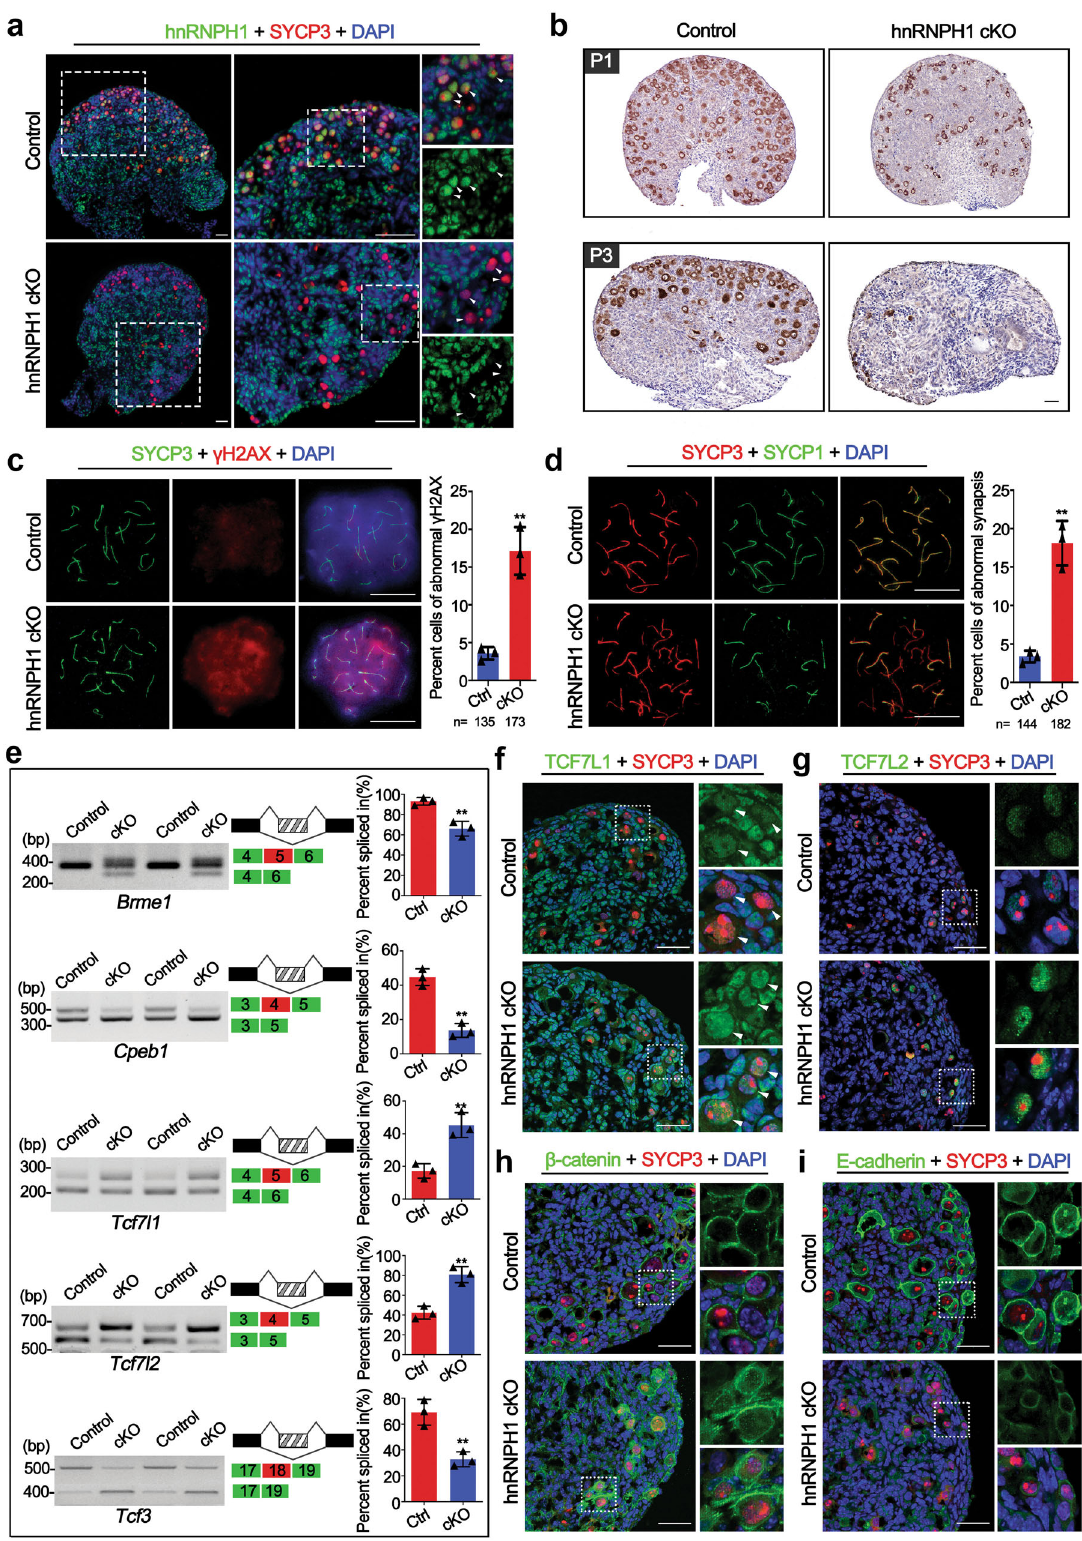
(Supplementary Fig. S11c), suggesting a splicing-independent mechanism underlying hnRNPH1 regulates gene expression. Since PTPB2 has a similar role in RNA alternative